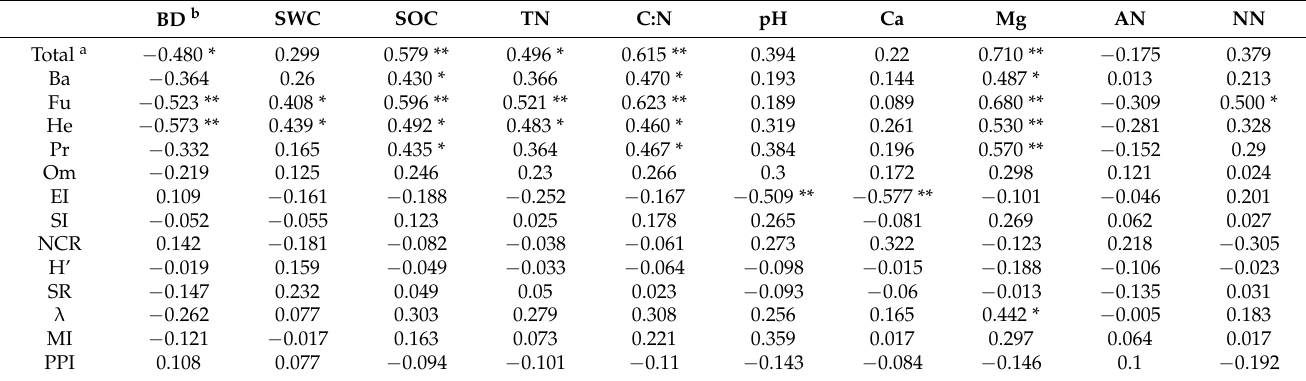
Table 2. Pearson’s correlation coefficients between soil physicochemical properties and soil nema- tode